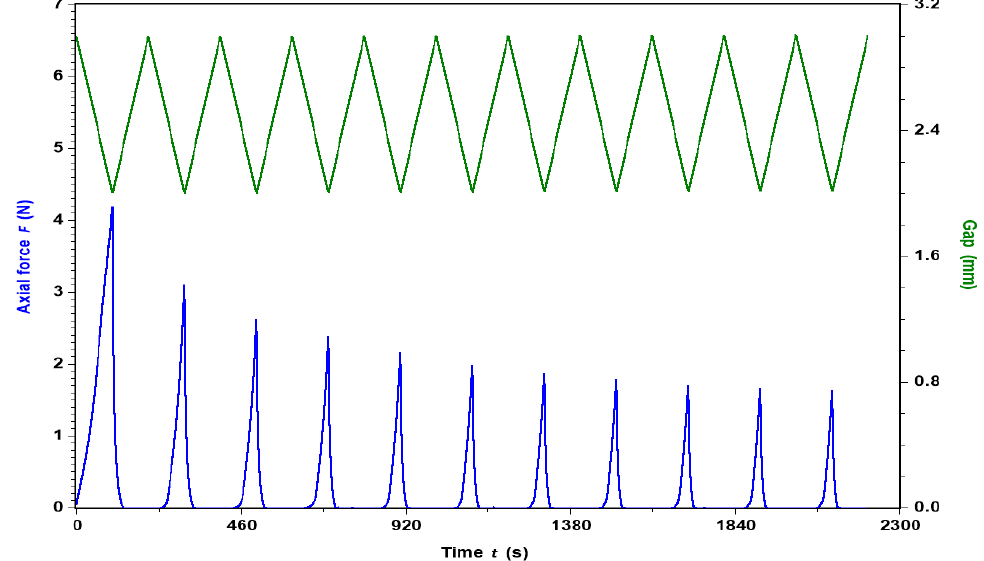
Figure 2. Fatigue test applied onto APP-E at pectin concentration of 10 g L − 1 in 1 mol L − 1 CaCl 2 and at T = 25 °C.